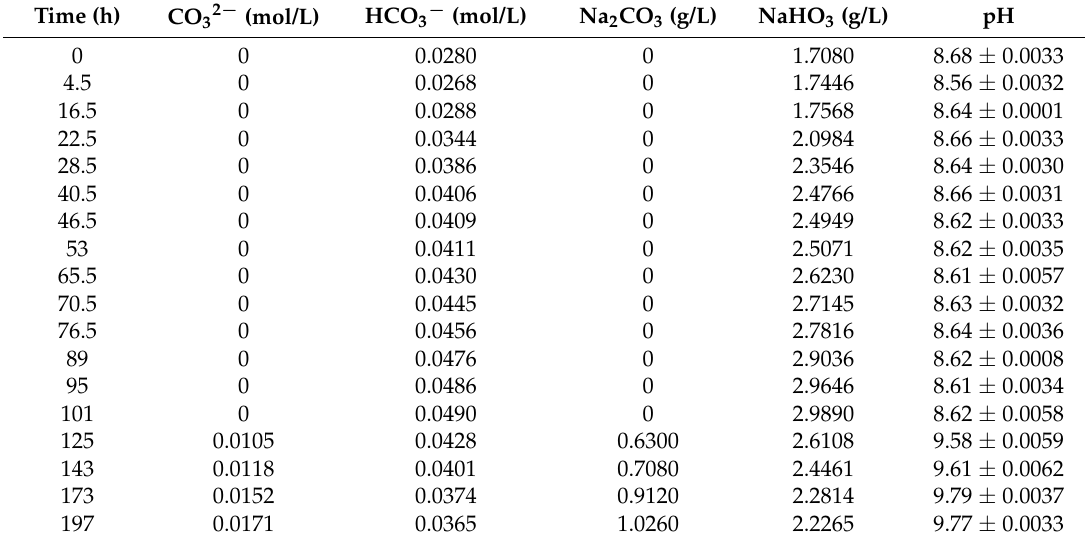
Figure 4. Physiological and biochemical characteristics of B. licheniformis . ( a ) The black line represents the cell growth curve (purple symbols); the red line represents the pH value of the experimental group and the black line (black symbols) represents the pH value of the control group; the dark green line represents the pH value based on the concentration of carbonate and bicarbonate ions; the blue line represents the pH value based on the concentration of NH 4+ ; ( b ) the curve of CA activity; ( c ) the curve of carbonate and bicarbonate concentration; ( d ) the curve of NH 4+ concentration. Table 1. pH values based on the concentrations of bicarbonate and carbonate ions.